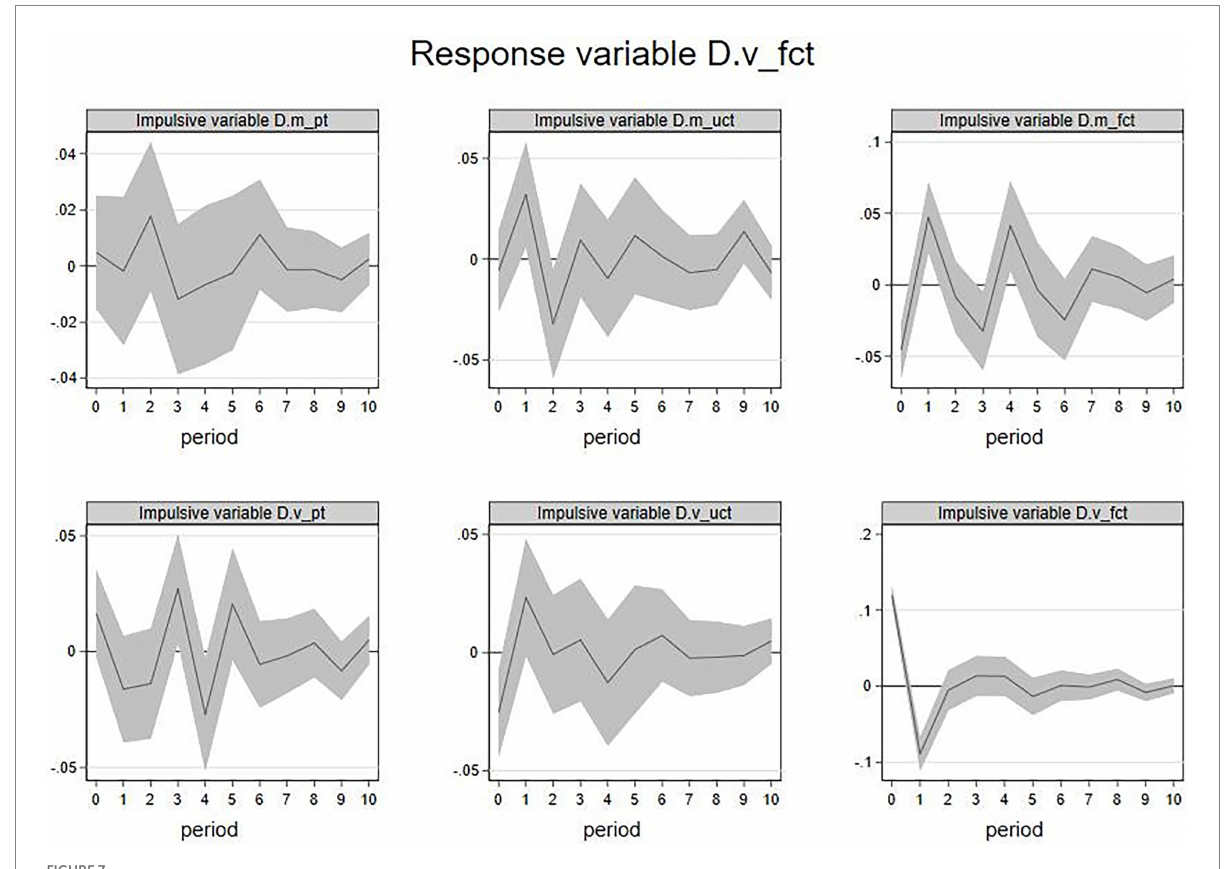
FIGURE 7 IRF: _ D.v fct (response variable).